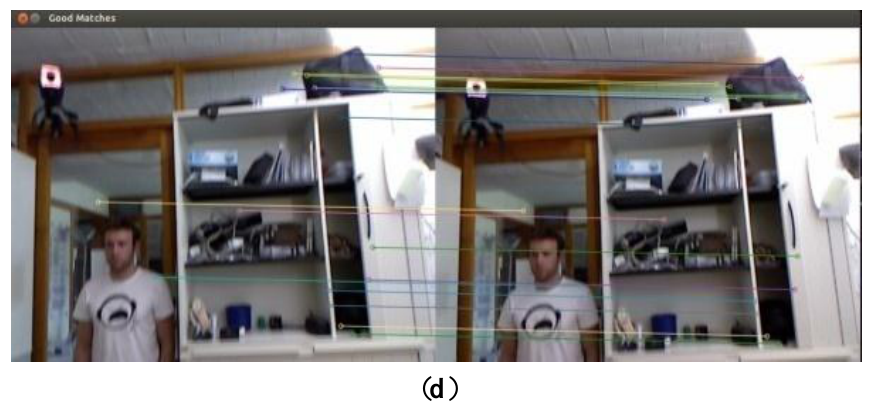
Figure 6. Results for BruteForce feature matching. ( a ) No threshold filtration; ( b ) 10 times the minimum distance; ( c ) Five times the minimum distance; ( d ) Two times the minimum